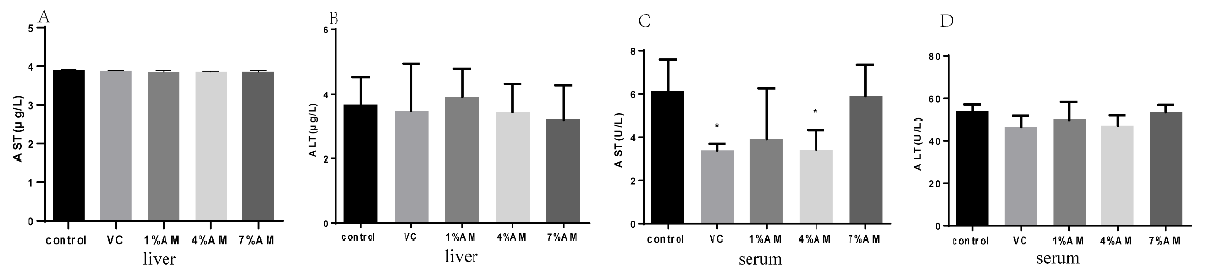
Figure 2. Effects of feed supplemented with AM on AST and ALT of laying hens. Values are shown as mean ± SD ( n = 6). Significant differences compared to control group are designated as * show significant difference at p < 0.05. AST content in liver ( A ), ALT content in liver ( B ), AST content in serum ( C ), ALT content in serum ( D ). Abbreviations: AST, Aspartate aminotransferase; ALT, Alanine aminotransferase.